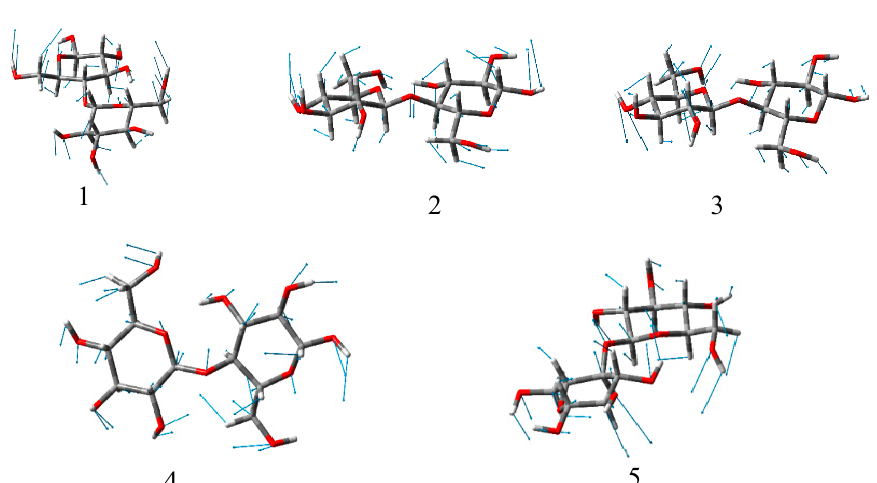
Figure 8. Calculated THz peaks of cellulose in the 0–3 THz frequency range. Lorentzian line shapes convolved into all modes to provide a visual guide.